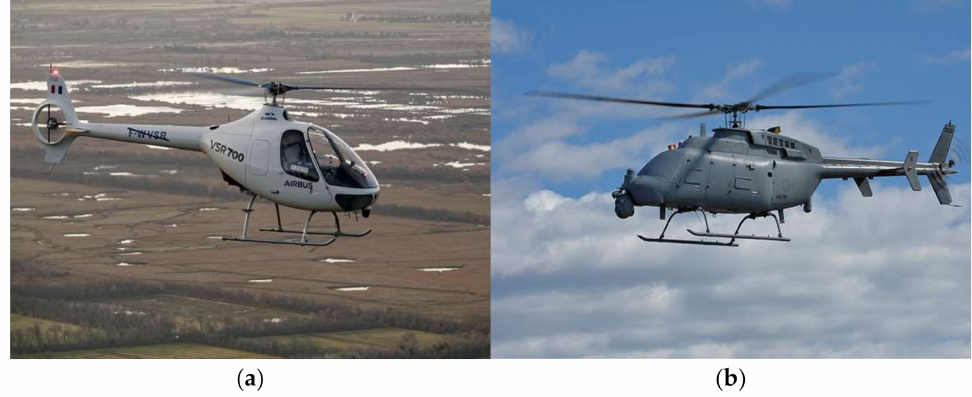
Figure 1. Examples of Rotary UAV systems: ( a ) The Airbus VSR700. Photo courtesy of Airbus [1], ( b ) The Northrop Grumman MQ-8C Fire Scout. Photo courtesy of Northrop Grumman [2].